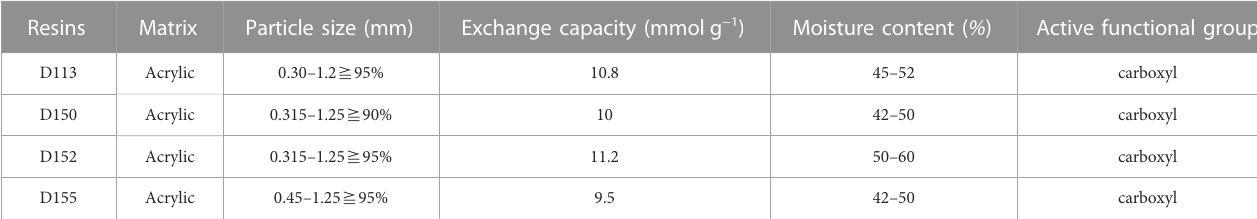
TABLE 1 Different cation exchange resin parameters.